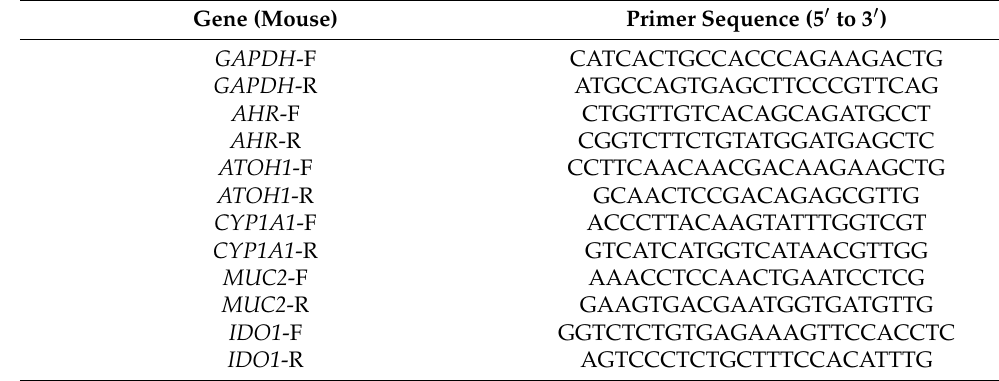
Table 1. The primer sequence used for the evaluation of mRNA sequence of this article. Gene (Mouse) Primer Sequence (5 (cid:48) to 3 (cid:48) ) GAPDH -F CATCACTGCCACCCAGAAGACTG GAPDH -R ATGCCAGTGAGCTTCCCGTTCAG AHR -F CTGGTTGTCACAGCAGATGCCT AHR -R ATOH1 -F ATOH1